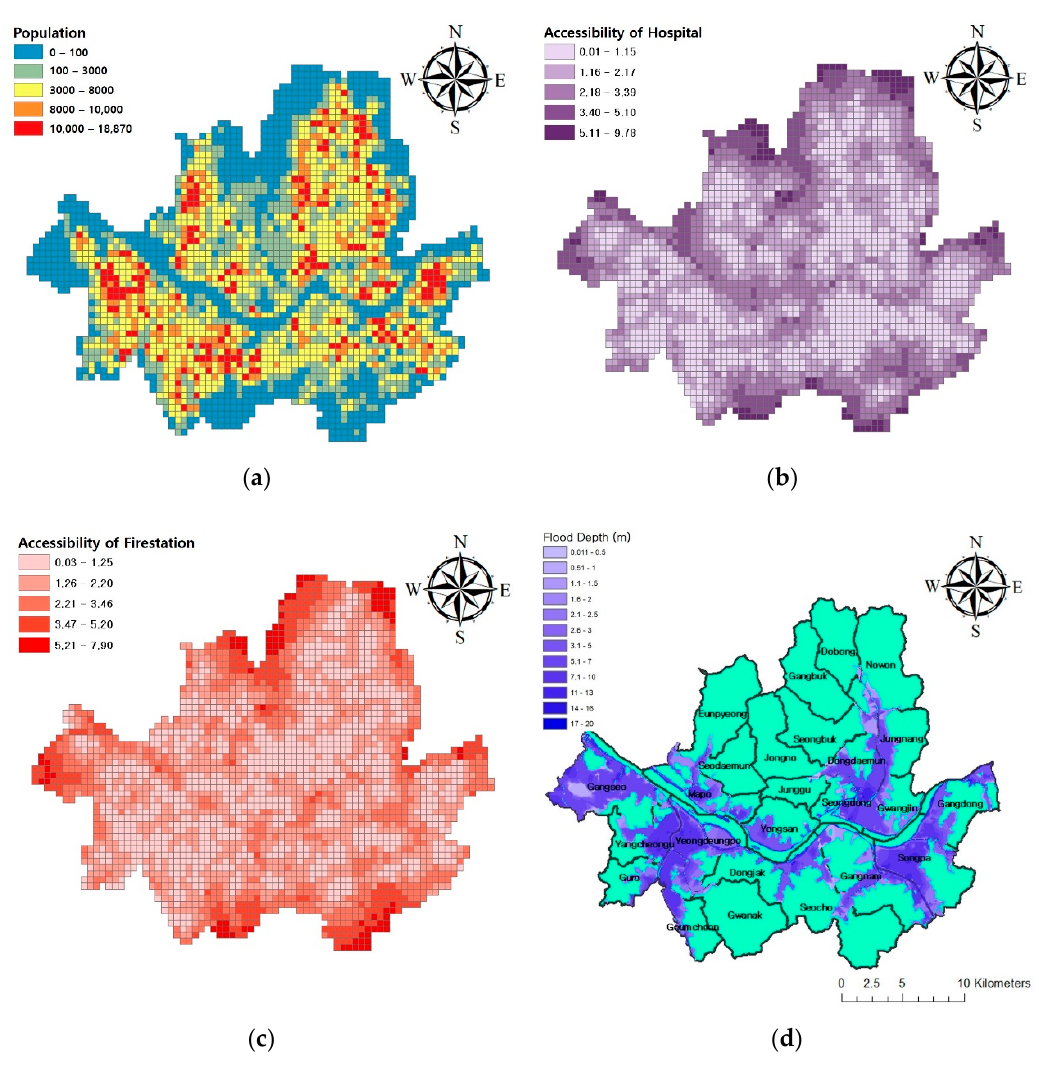
Figure 12. Factors in estimating flood risk. ( a ) Population; ( b ) hospital accessibility; ( c ) fire station accessibility; ( d ) flood map overlapping.